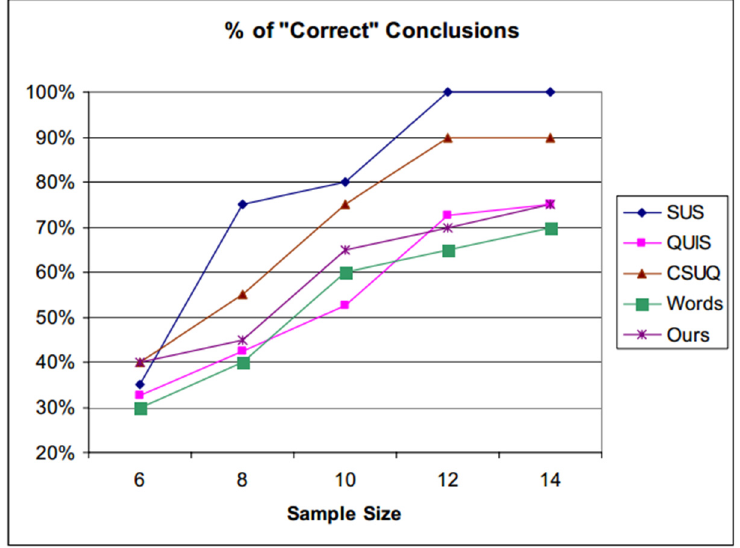
Figure 6. Correct conclusion comparison [40].